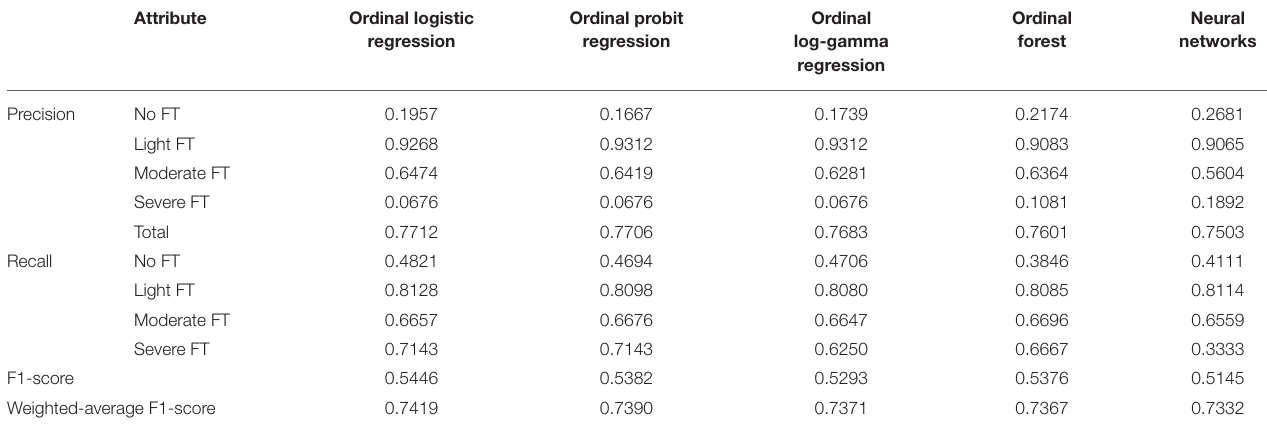
TABLE 4 | Out-of-sample correct classification rate for each machine learning